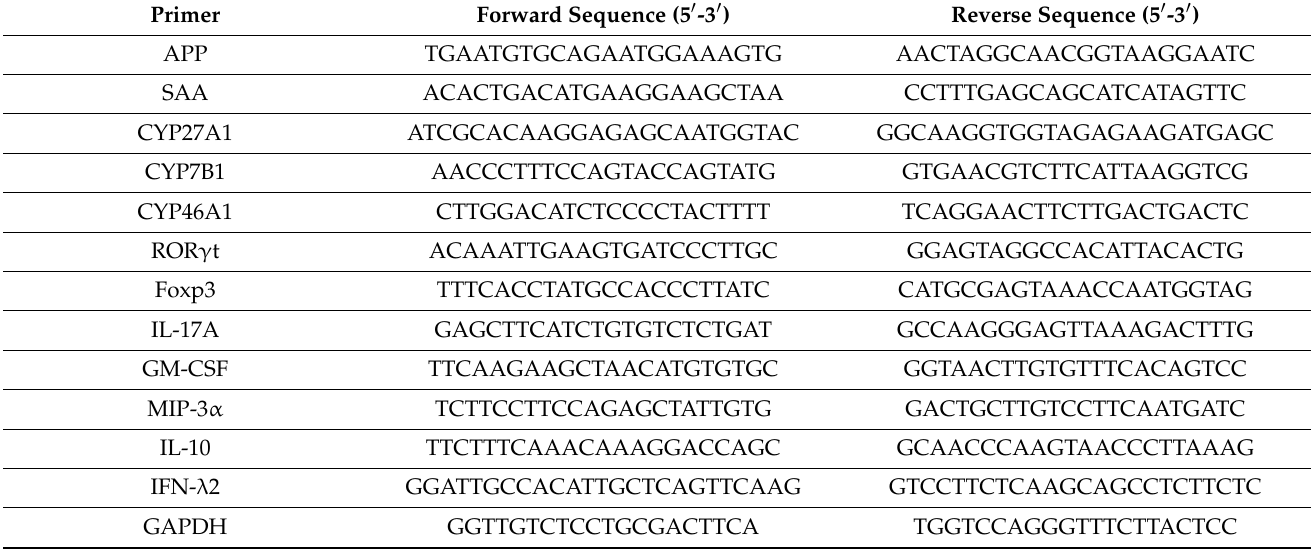
Table 2. Primers used in this